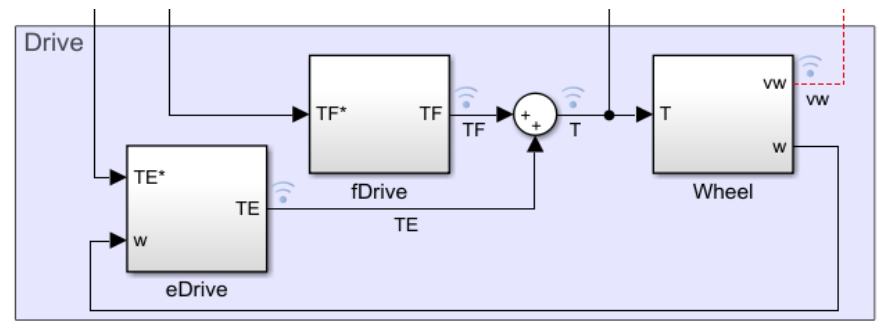
Figure 2. The physics-based Simulink ® model of the vehicle.